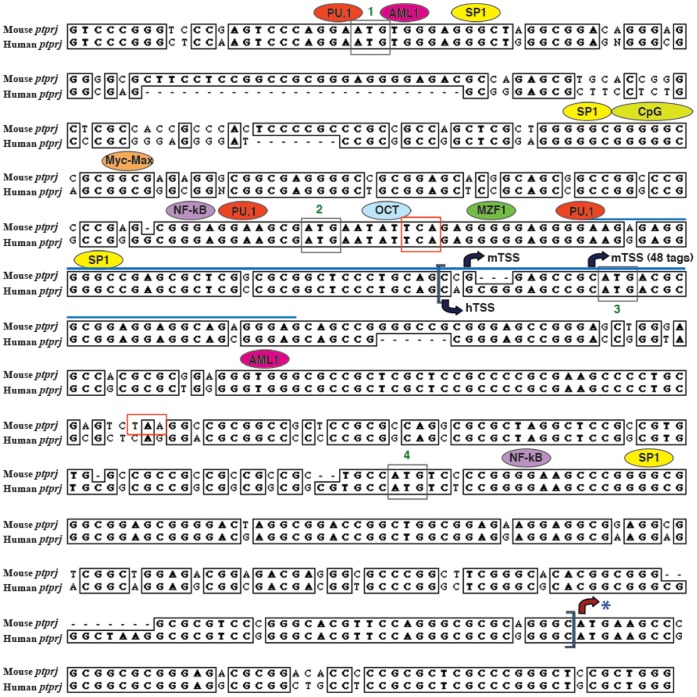
Clustal W alignment of the mouse and human Ptprj putative promoters.Consensus transcription factor binding sites conserved in sequence and position between mouse and human were predicted using RVista browser and TRANSFAC. Only the myeloid-specific transcription factors have been shown in this figure. Evolutionary conserved region (ECR1) lies within the blue brackets. Blue line marks the region of transcription start site (TSS) cluster represented in Figure 6. mTSS refers to the transcription start site for mouse ptprj and hTSS to the transcription start site for human Ptprj predicted by CAGE analysis. The four uAUG codons are highlighted within grey boxes and the stop codons within red boxes. Asterisk (*) represents the translation start site. The boxes represent the conserved sequences between mouse and human. N represents any nucleotide.